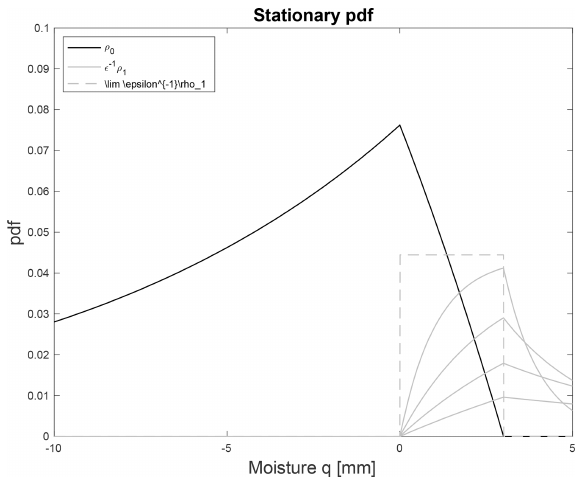
Figure 3. Stationary probability density functions (pdfs) for the ρ ∞ density (black line) and (cid:15)ρ ∞ density for values of (cid:15) = 0 1 1 , 0 . 5 , 0 . 25 , and 0 . 1 (gray lines). The dashed line is the limit shape of the ρ ∞ density scaled by (cid:15) − 1 . 1